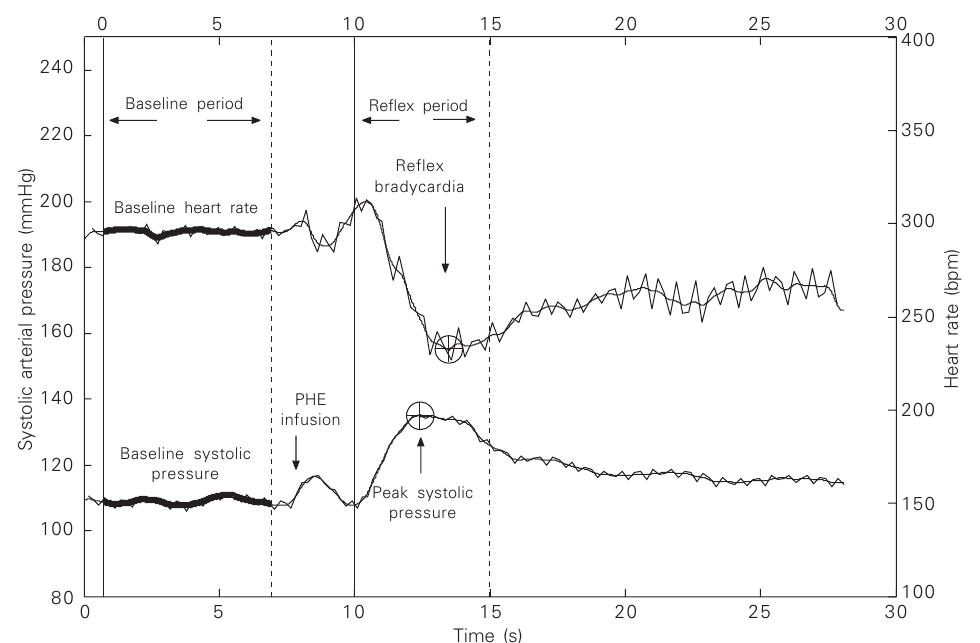
Figure 1. Example of the rou- tine graphic interface during one experiment with a bolus infusion of phenylephrine. SBP and HR time series were pre- sented to the user who de- fined the beginning (continu- ous) and the end (dotted) of the baseline and reflex periods, limited by vertical lines. The al- gorithm calculated the SBP and HR for baseline average values (thick line) and the SBP and HR peak values (shown as a circle and cross on the lines) and the baroreflex index shown at the top of the figure. PHE = phen- ylephrine; SBP = systolic blood pressure; HR = heart